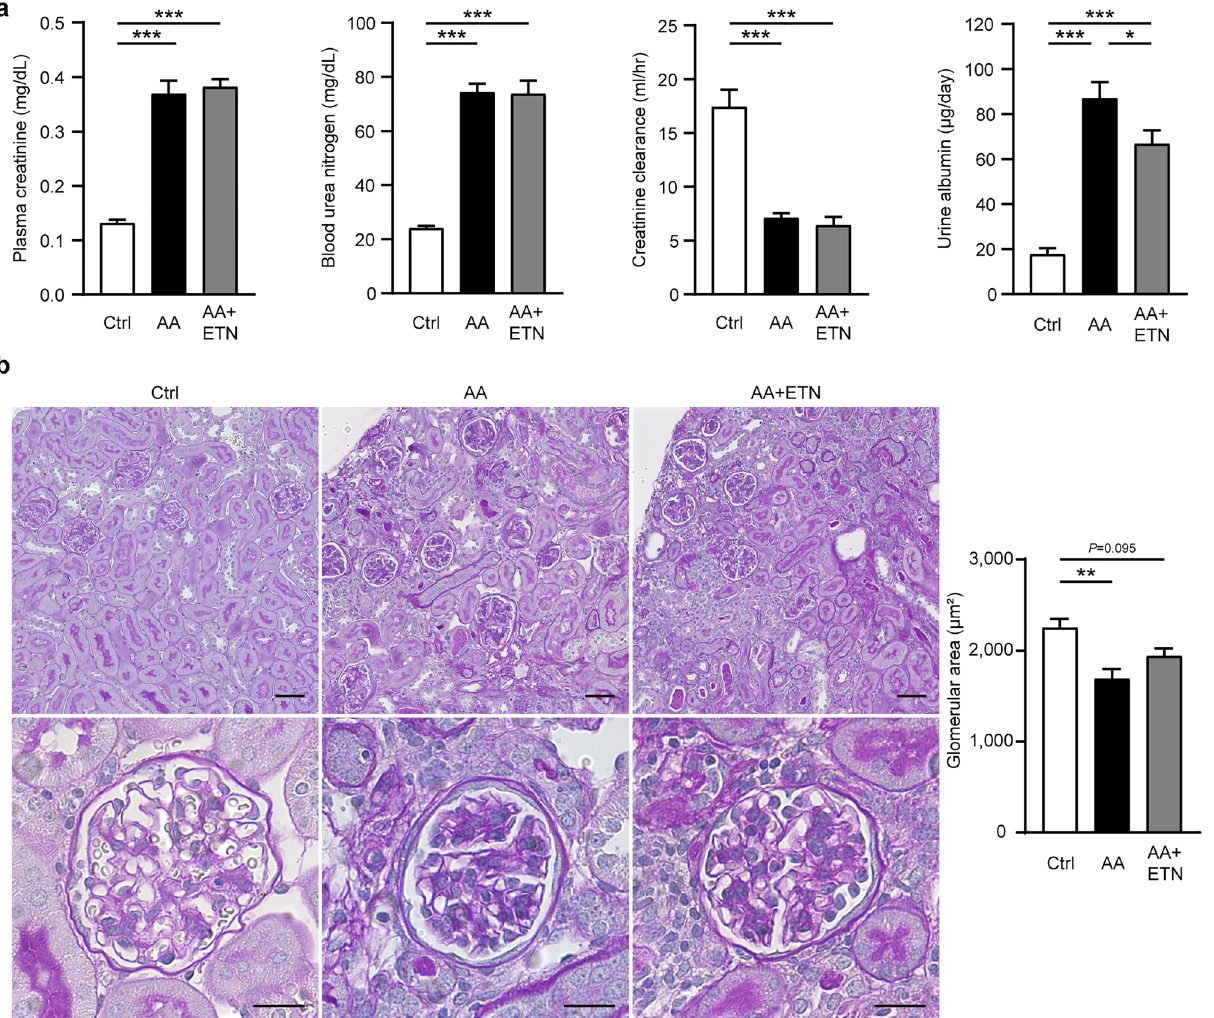
Figure 2. Effect of etanercept on renal function and pathological changes. ( a ) Kidney function as determined by plasma creatinine, blood urea nitrogen, creatinine clearance, and urine albumin ( n = 7–8). ( b ) Representative images of kidneys stained with PAS (upper panel, original magnification, × 200, bar, 50 μm; lower panel, original magnification, × 400, bar, 20 μm), and quantitative analysis of glomerular area ( n = 6–8). Values are means ± SEM. * P < 0.05, ** P < 0.01, *** P < 0.001. Ctrl, control; AA, aristolochic acid; ETN, etanercept; PAS, periodic acid